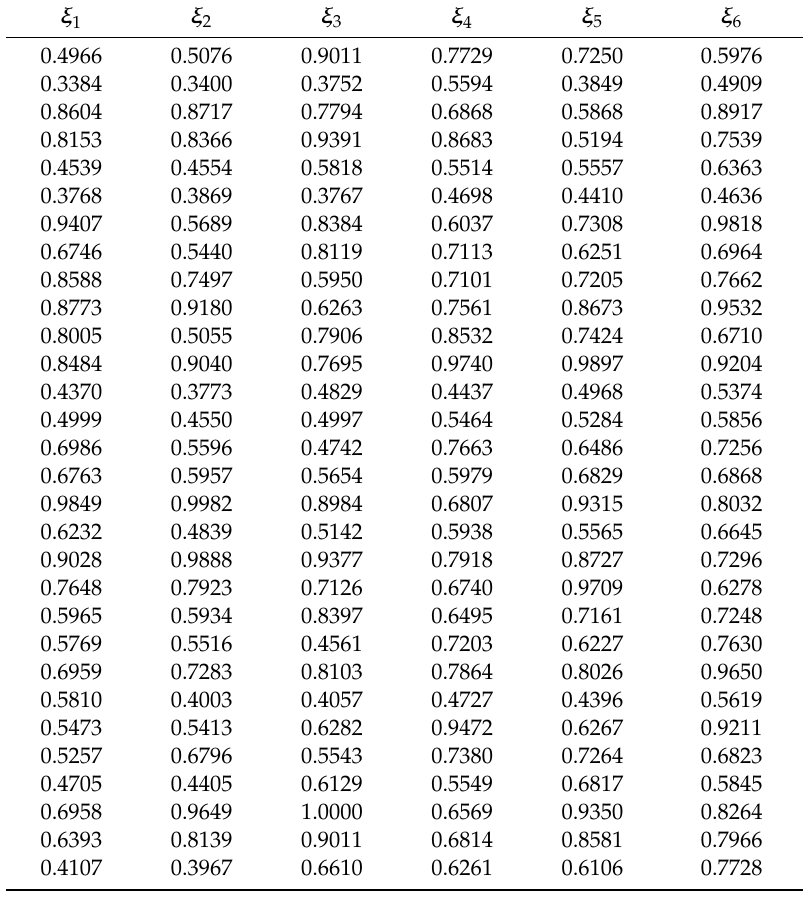
Table 4. Correlation coe ffi cient matrix of LVC-qZSI parameters.